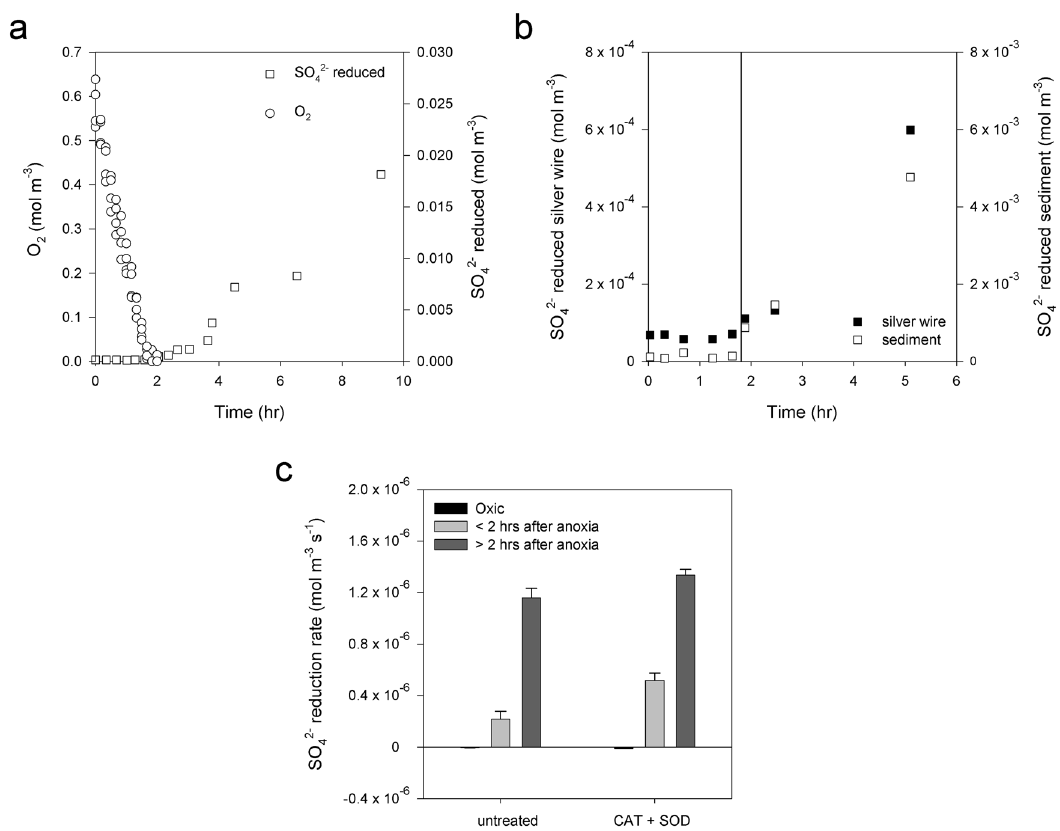
Fig. 4 | In fl uence of oxygen (O 2 ) on respiration. a Oxygen concentrations (open